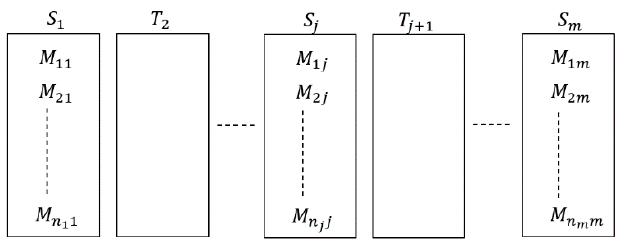
12 of 16 Figure 10. (cid:1845)(cid:1829)(cid:1844)(cid:3554) expected using our technology. 7. Discussion By using our simple metric in order to evaluate and compare between architectures, we found that waveguide crossings are critical components, especially in large-scale switches. Lu and Thompson in [15] and Kabacinski in [17] did not consider the effects of waveguide crossings in their SNR calculations. With these obtained results, we underline its strong influence on the LS-MZS performances. Indeed, S&S is a simple architecture that reduces the crosstalk induced by MZIs, but the central interconnection, composed of a large number of waveguide crossings, considerably limits the overall performance of the network. The high number of waveguide crossings also influences the performance of dilated Beneš. DLN offers the right compromise in terms of stage count, crossing count, and total cumulative crosstalk. Yet, the total number of MZIs increases rapidly. Furthermore, we can also determine the maximum crosstalk and loss values of each component in order to design an LS-MZS of order N. Author Contributions: M.K.: computation of the analytical SCR formula and numerical cross-checks. B.C.: supervision of the computation and interpretation of the results. C.A. direction of the work and supervision of the overall study. All authors have read and agreed to the published version of the manuscript. Funding: This work was supported by the French national program ‘programme d’Investissements d’Avenir’, IRT Nanoelec ANR-10-AIRT-05. Conflicts of Interest : The authors declare no conflict of interest